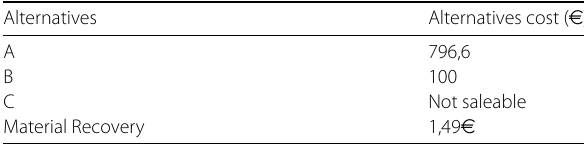
Table 5 Alternatives resale prices per